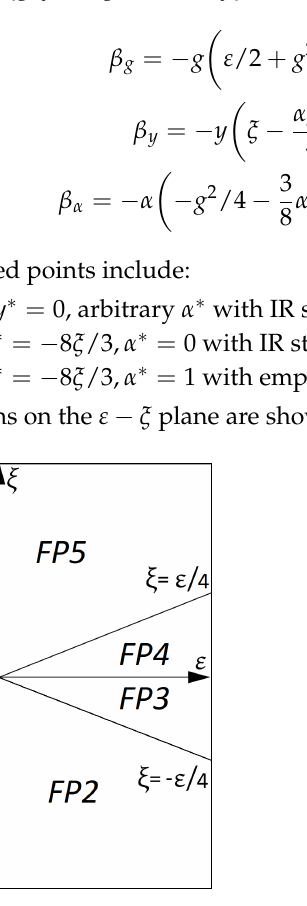
Figure 1. IR stability regions of the fixed points for the renormalized theory